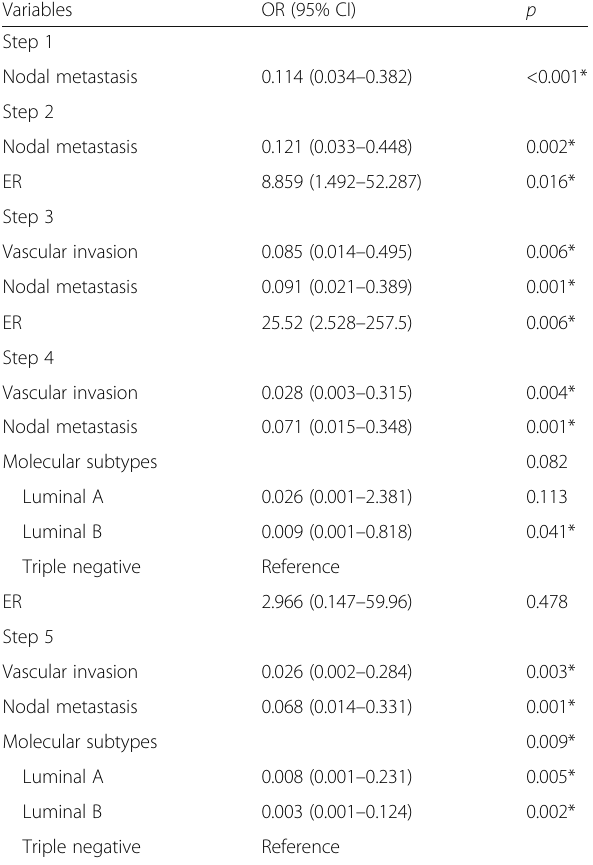
Table 6 Multivariate analysis of clinicopathological data and CD163 positive TAMs within tumor stroma